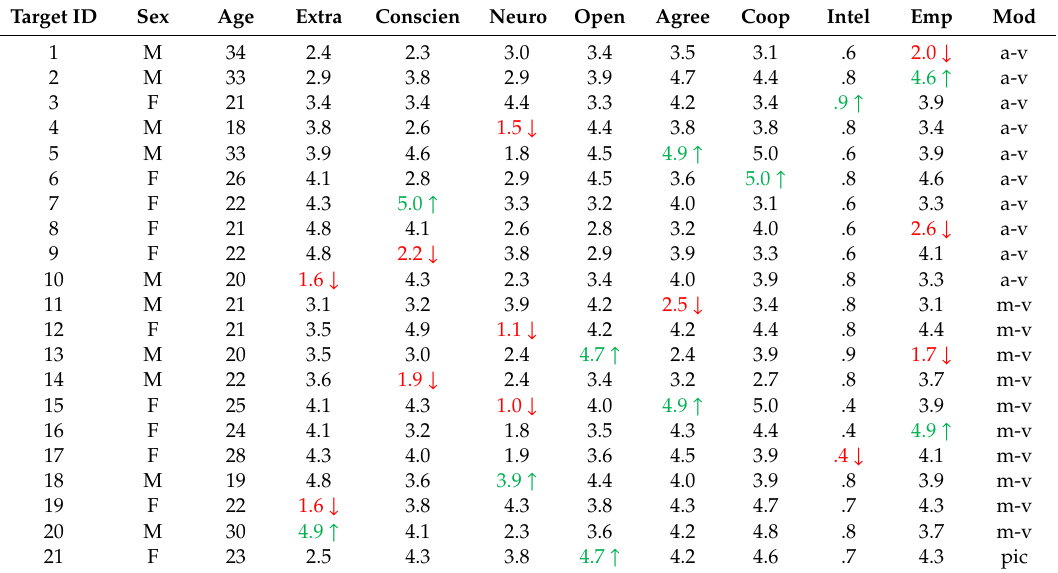
Table A1. Demographic and Personality Characteristics of the 30 Targets Used in the Personality Judgment Accuracy